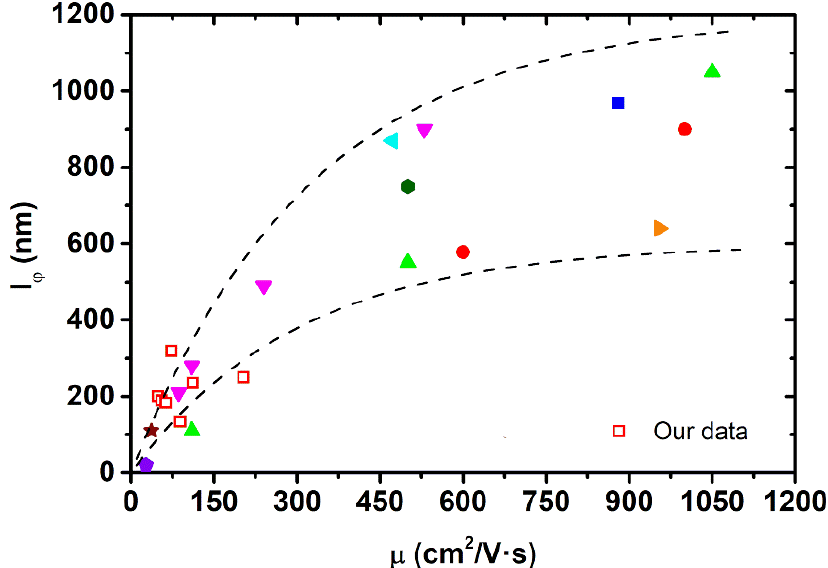
Figure 11. Representation of the phase coherence length l ϕ versus mobility µ values for different films. The dashed black lines are guides for the eyes. Red empty squares correspond to data obtained in our samples. The rest have been taken from literature: Red circles, [13]; blue square, [30]; light green upwards triangle, [31]; cyan left-pointing triangle, [42]; downwards magenta triangles, [54]; right pointing orange triangle, [56]; dark green hexagon, [64]; violet pentagon, [69]; maroon star, [70].